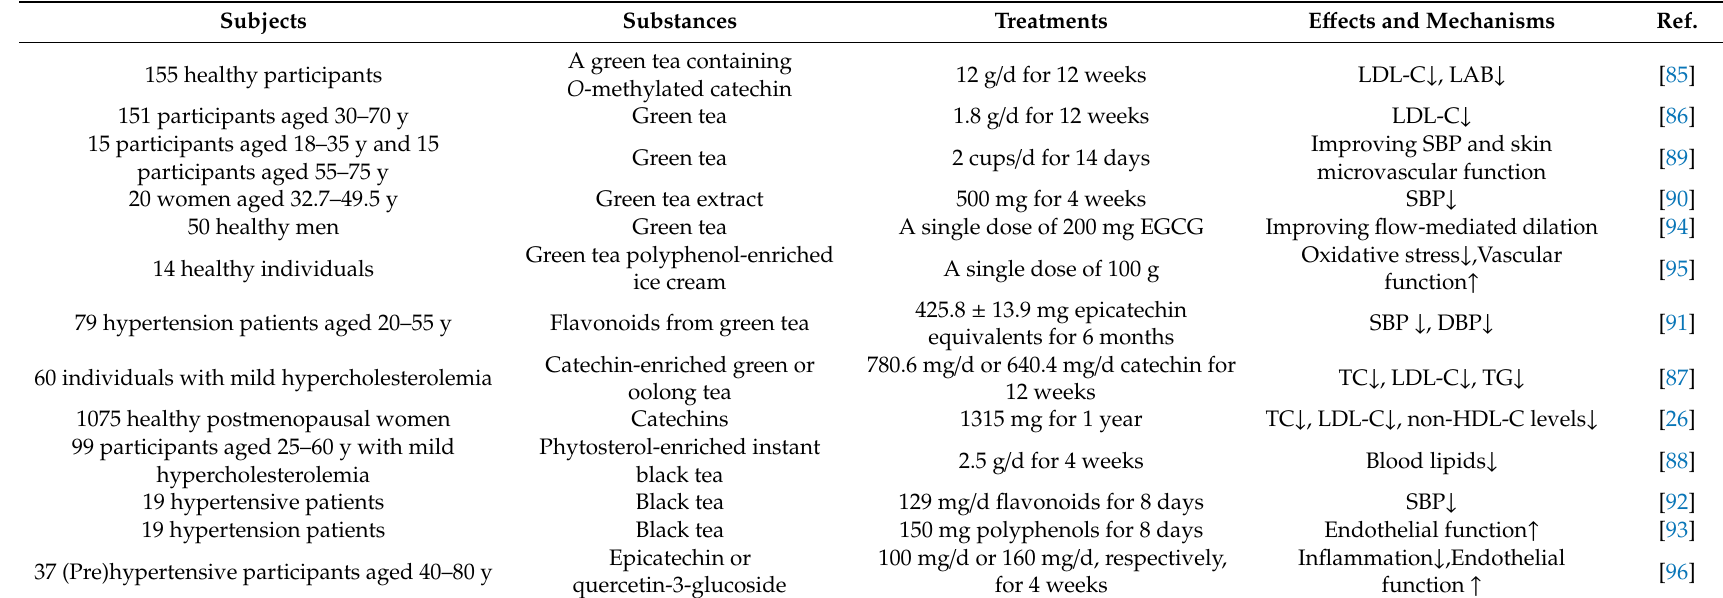
Table 3. The e ff ects of tea against CVDs based on clinical